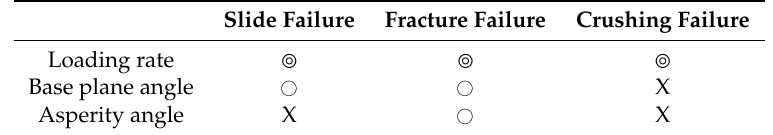
Table 6. Significant factors a ff ecting the dynamic peak strength for various failure